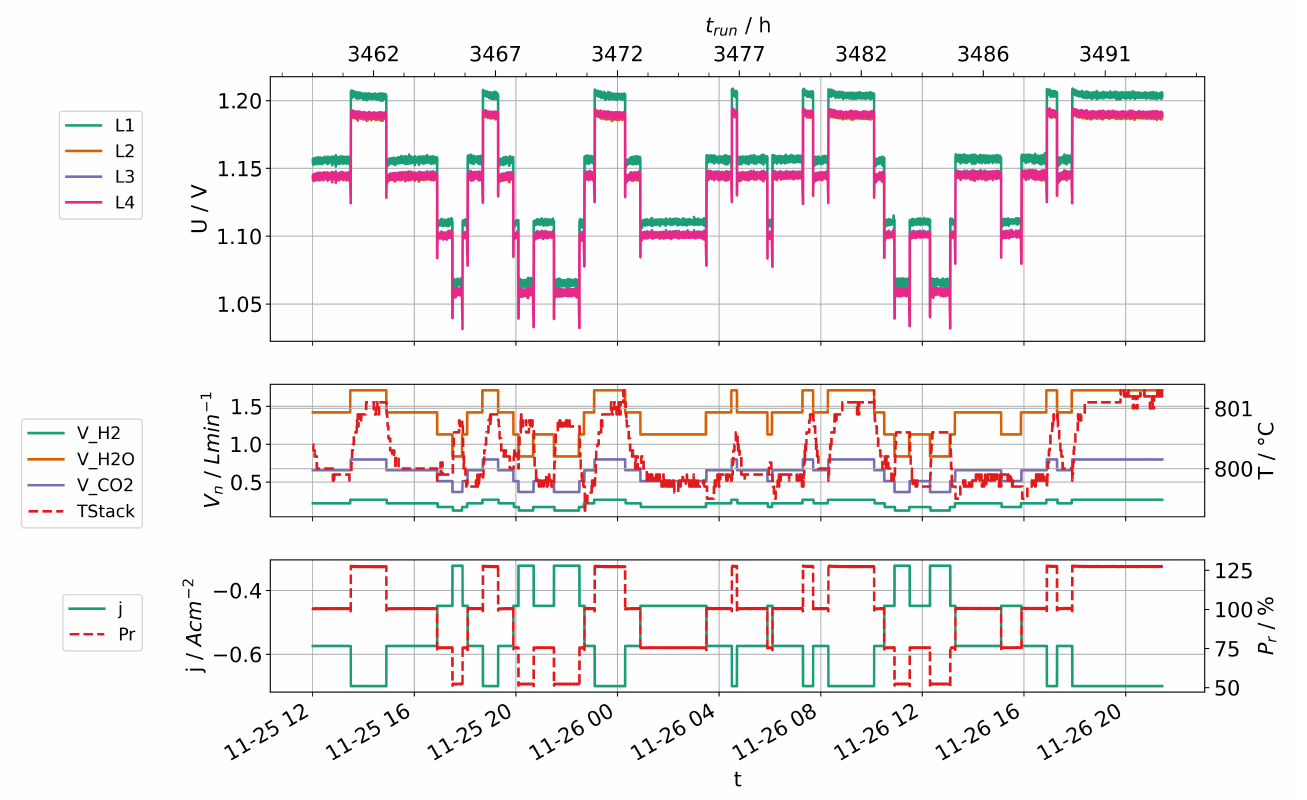
Figure 5. Single sequence of load changes at stack B. The cell potentials (top), feed gases and stack temperature (center), current density and relative stack power (bottom) are shown. (Curves for the layers two and three are overlaid by the one for layer